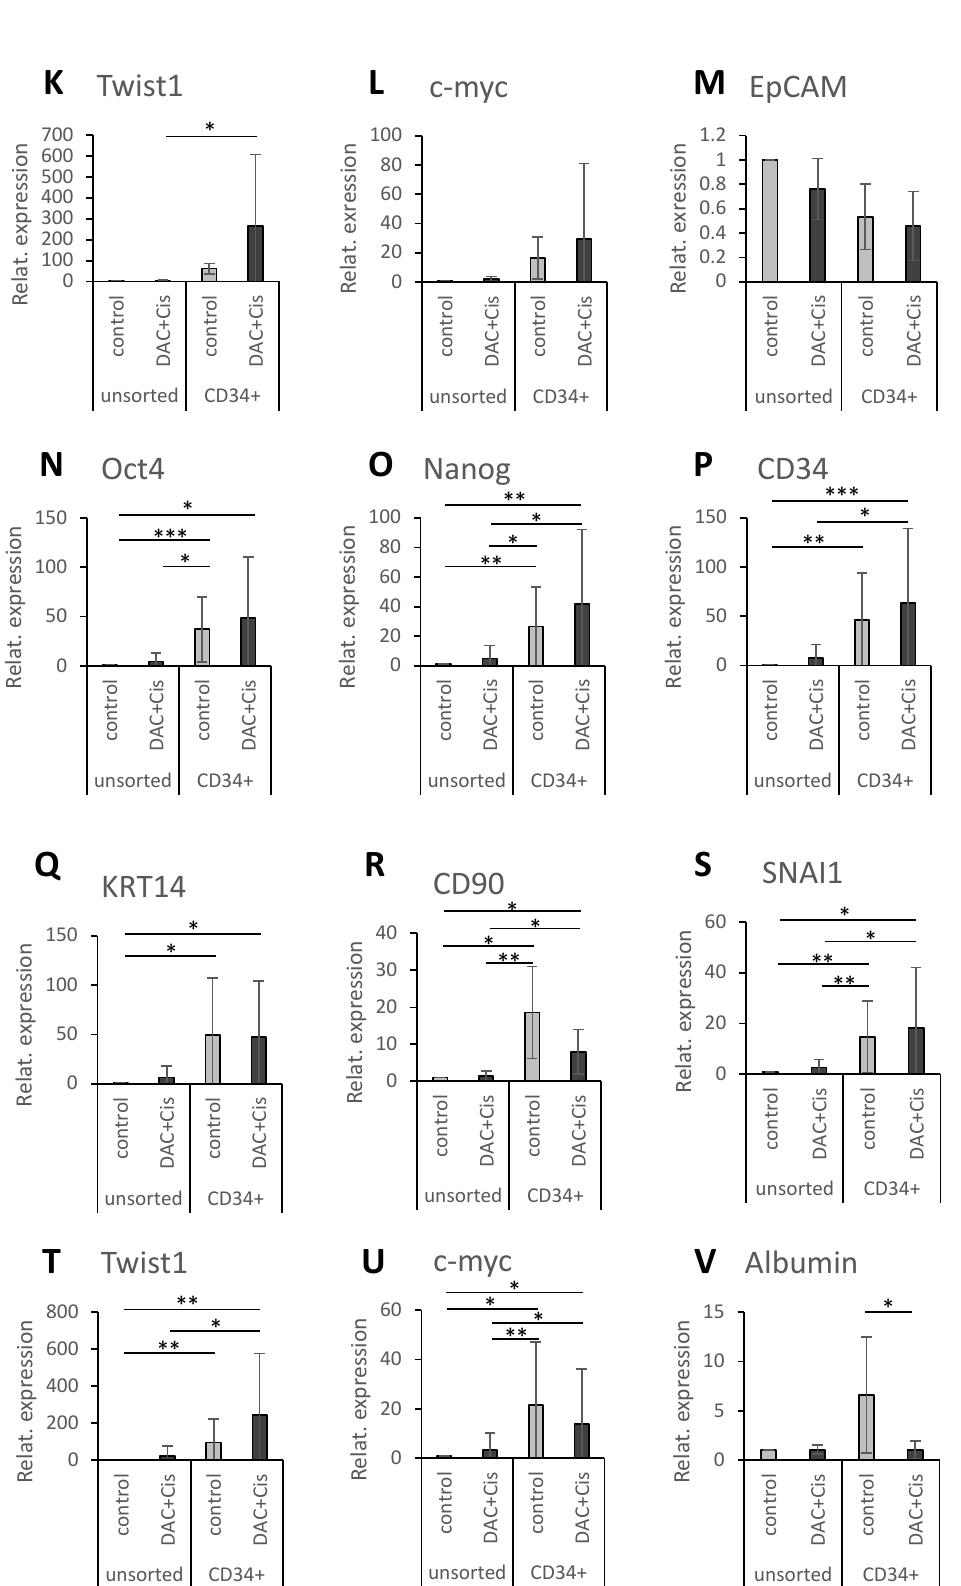
Figure 5. CD34 +/low OV-6 low CD90 + population reveals increased expression of pluripotency and EMT markers, but not compared to CD34 +/high OV-6 high CD90 + csVimentin + PD-L1 + CSCs. HuH6 cells were treated with 100 nM decitabine and 2 µ g/mL cisplatin, and HepG2 cells were treated with 250 nM decitabine and 3 µ g/mL cisplatin. After 72 h, the cells were sorted for CD34 using the